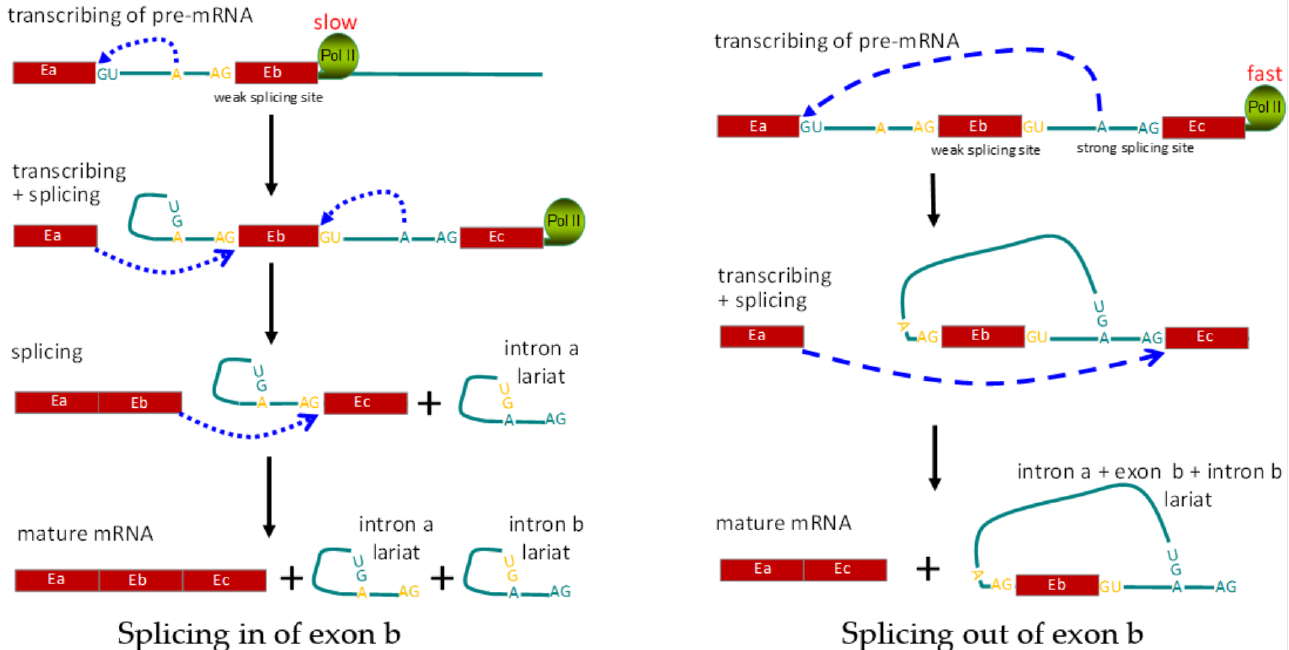
Figure 4. Schematic diagram showing regulation of alternative splicing at the co-transcriptional level. Left panel shows the normal splicing to include all three exons. Right panel shows exclusion of exon Eb, due to alternative splicing mediated by RNA Pol II speed. E: exon; A: branching site for RNA splicing; Pol II: RNA polymerase